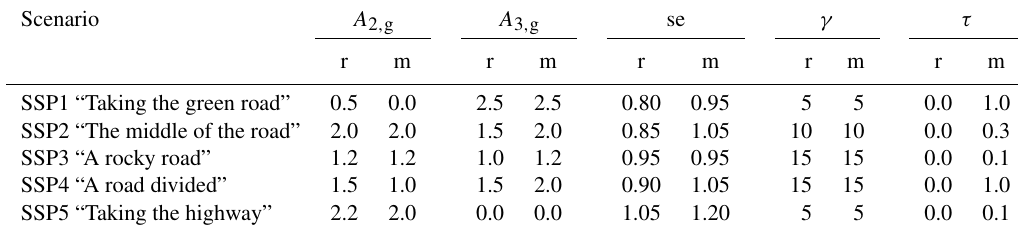
Table 3. Parameter settings in the climate–economy model (see Table 1) for reference (r) and mitigation (m) scenarios based on the SSPs and the challenge for adaptation (damage elasticity factor, γ ) and mitigation (carbon tax, τ , as a proportion of optimum, for mitigation scenarios). Scenario A 2 , g A 3 , g se γ τ r m r m r m r m r m SSP1 “Taking the green